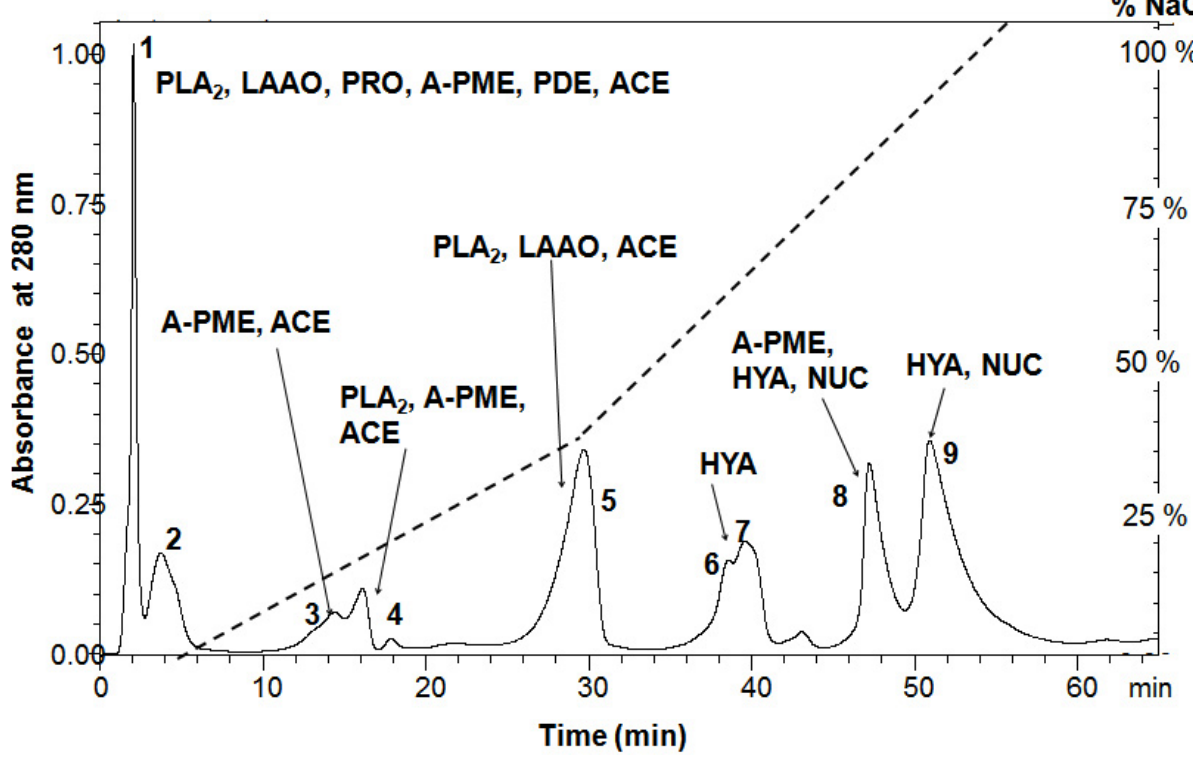
Figure 1. Resource® S cation exchange chromatography of N. sumatrana venom. Ten milligrams of N. sumatrana venom was injected into the column equilibrated with 20 mM MES, pH 6.0, and eluted by a linear gradient (0 to 0.8 M NaCl of 0-30% from 5 to 30 minutes, followed by 30-100% from 30 to 55 minutes). Flow rate was 1 mL/min. Dotted line: elution gradient. LAAO: L-amino acid oxidase; PLA PRO: protease; PDE: phosphodiesterase; NUC: 5’-nucleotidase; APME: alkaline phosphomonoesterase; HYA: hyaluronidase; ACE: